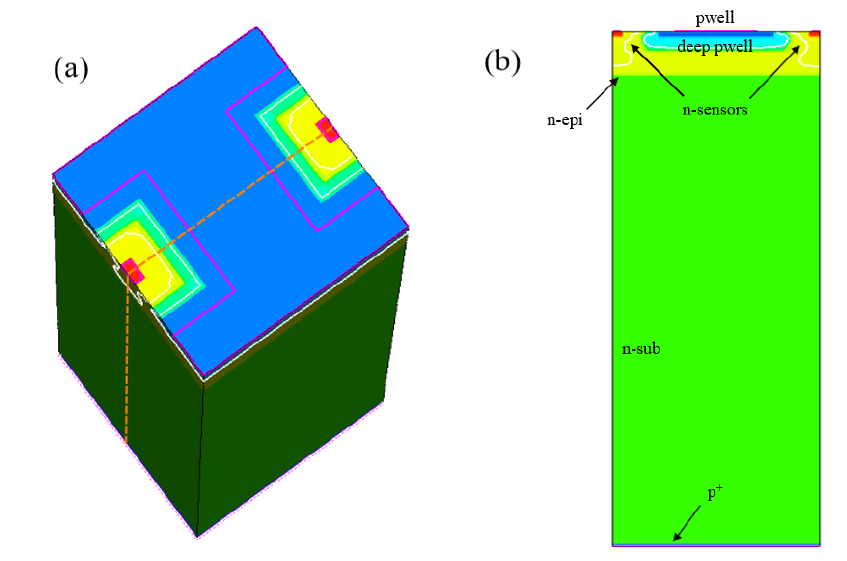
Figure 4. ( a ) 3D domain composed by two pixel halves. The red and blue regions represent the pixel nwells and pwell, respectively. The boundary of the depletion region is marked with white lines. The dashed orange lines represent the edges of the cross section cut plane. ( b ) 2D cross-section (Not to